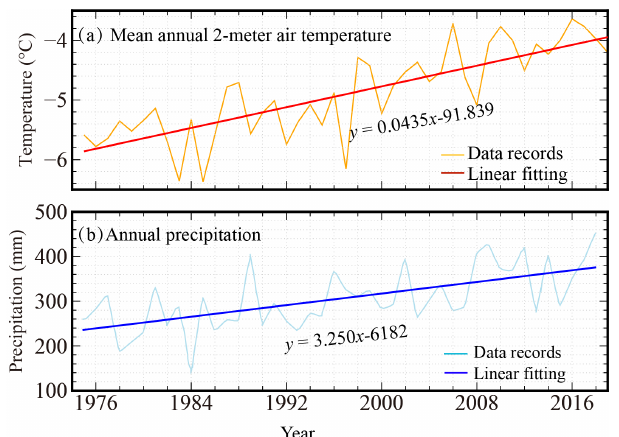
Figure 11. Mean annual 2m air temperature (a) and annual precip- itation (b) at the Wudaoliang meteorological station (4613ma . s . l . ) about 60km south of the KLP-37 glacier. The equations represent the best-linear-fitting model of the data records.